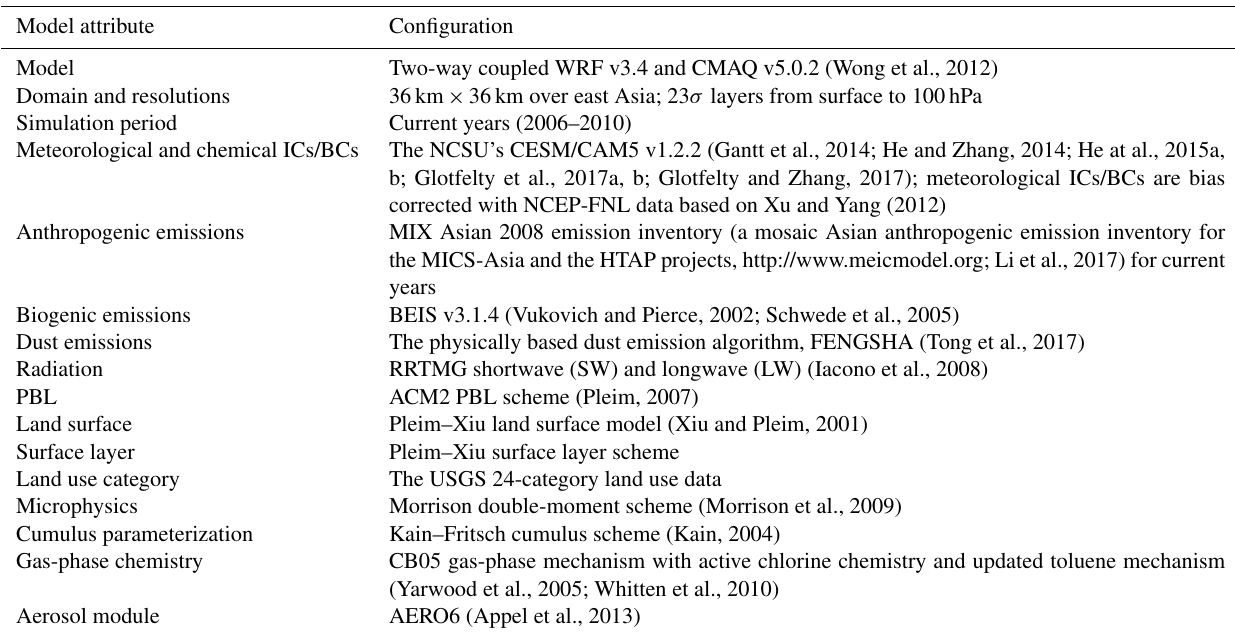
Table 1. Model configurations and setup for the climatological